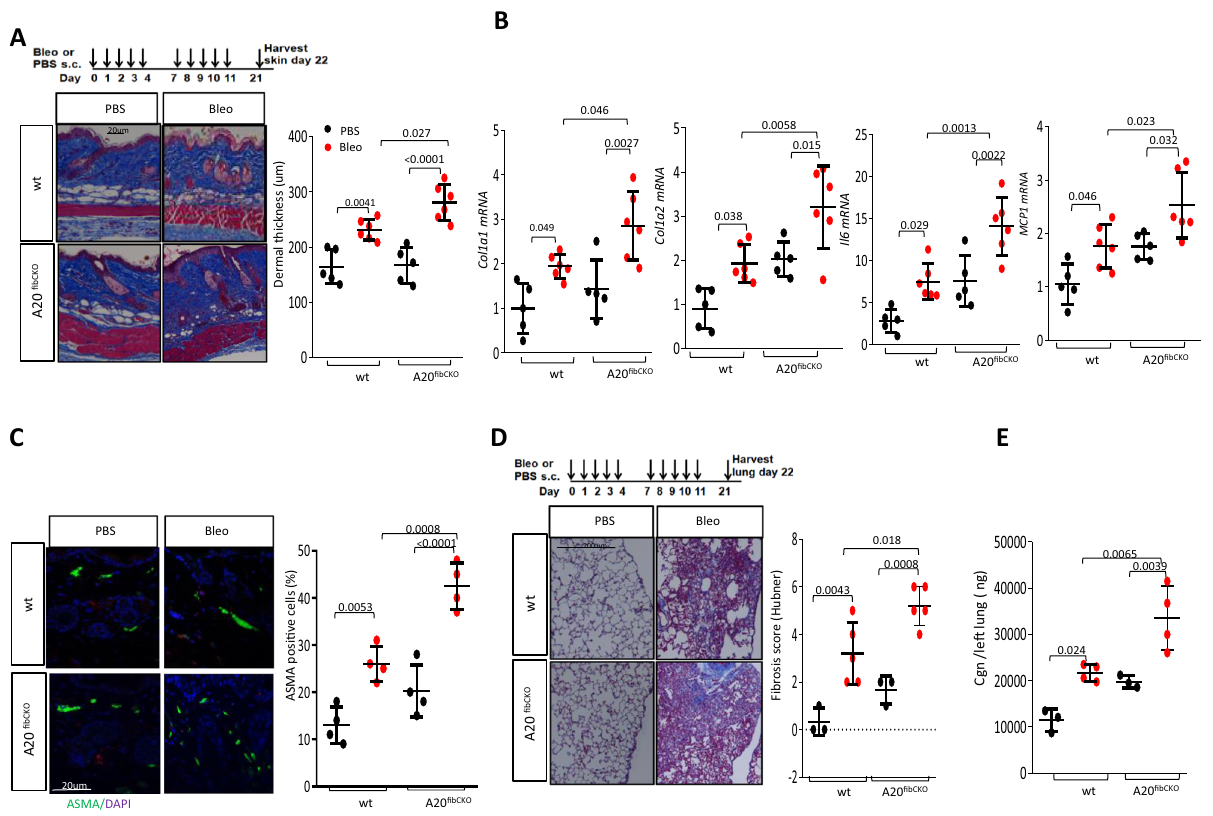
Fig. 4 | Mice with fi broblast-speci fi c A20 ablation show exaggerated skin and lung fi brosis. A20 fl / fl (wt) mice and A20 fi bcko mice were in parallel treated with s.c. bleomycin (5mg/kg) or PBS for 2 weeks (5 days/week), and lesional skin and lungs were harvested on day 22 for analysis. A – C Skin fi brosis. A Top: schematic repre- sentation of the experiment. Left panels: Trichrome stain. Representative images. Bar=20 µ m. Right panel: dermal thickness (mean±SD of 5 determinations/hpf); n =5 (PBS-treated), n =6 (Bleo-treated). B qPCR. Results, normalized with GAPDH, aremean±SDoftriplicatedeterminations. n =5(PBS-treated), n =6(Bleo-treated). One-way ANOVA followed by Sidak ’ s multiple comparison test. C Left panel: immunolabeling with antibodies to ASMA. Scale bars=20 µ m. Right panel: